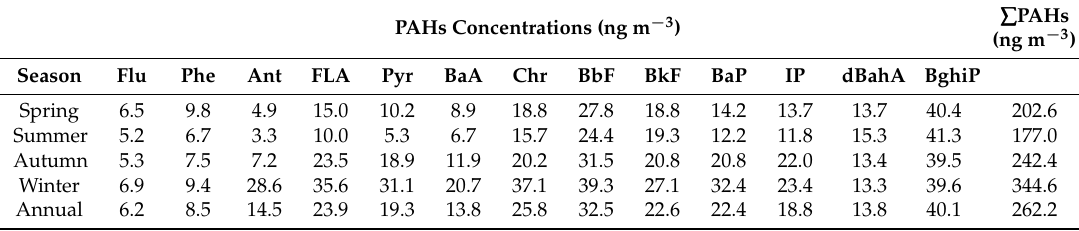
Table 1. Statistical summary for the mass concentrations of PAHs over four